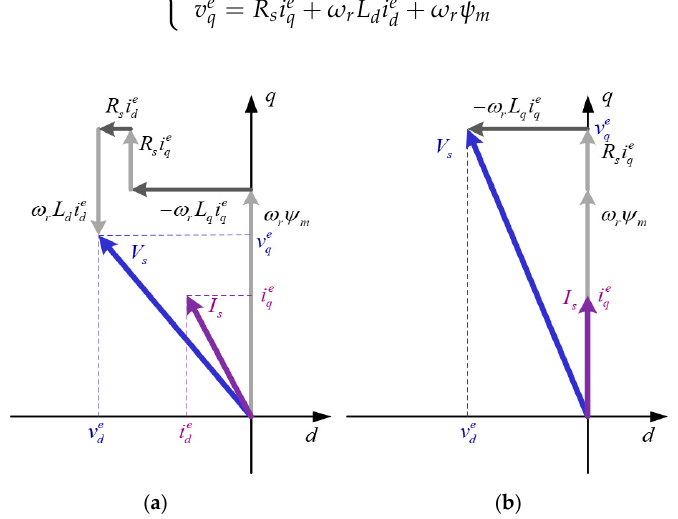
Figure 2. Voltage and current vectors when: ( a ) i ed < 0, i eq > 0; ( b ) i ed = 0, i eq > 0.